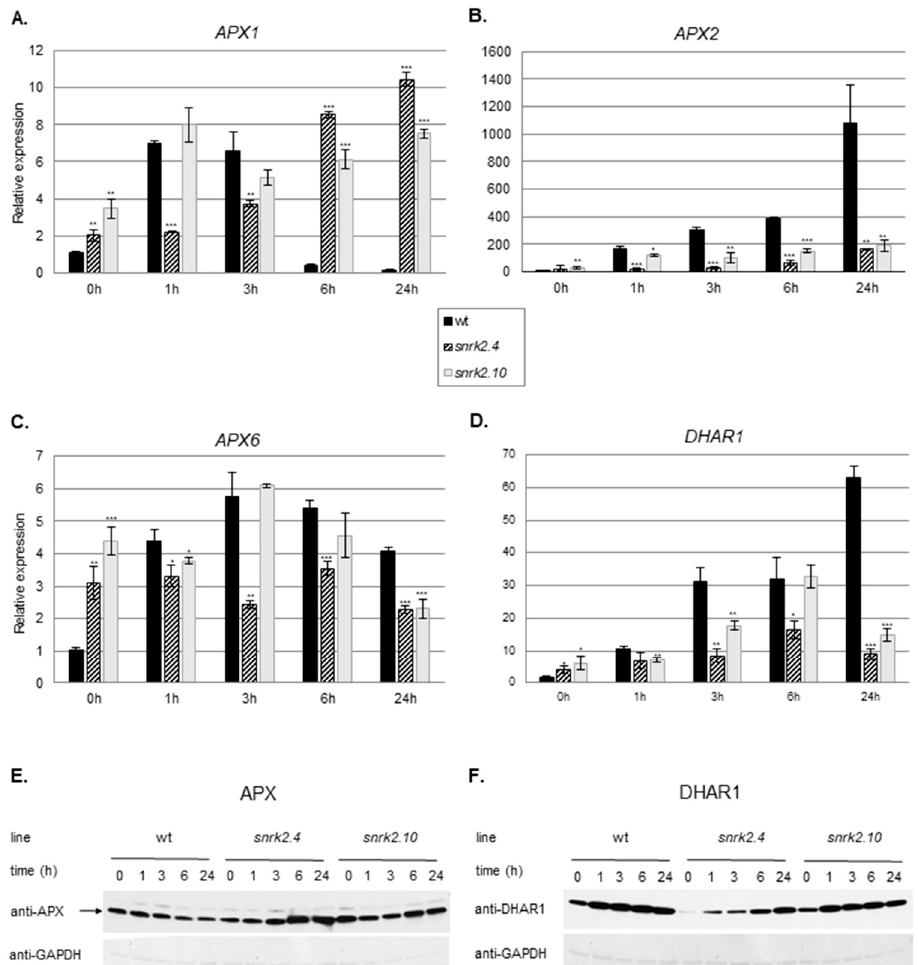
Figure 4. SnRK2.4 and SnRK2.10 regulate enzymes of the ascorbate cycle during response to salt stress. Wild type and snrk2 mutant seedlings were subjected to treatment with 150 mM NaCl for times indicated. Expression of ( A ) APX1 — Ascorbate Peroxidase 1 , ( B ) APX2—Ascorbate Peroxidase 2 , ( C ) APX6 — Ascorbate Peroxidase 6 , and ( D ) DHAR1—Dehydroascorbate Reductase 1 was monitored by RT-qPCR; error bars represent SD; stars represent statistically significant differences in comparison with the wt plants (Student t -test) where * p < 0.05; ** p < 0.001; *** p < 0.0001. Total protein level of ( E ) APX and ( F ) DHAR1 was monitored with immunoblot analysis; after exposure, membranes were stripped and reused for GAPDH detection as a loading control. At least two independent biological replicates of the experiment were performed. Results of one representative experiment are shown.